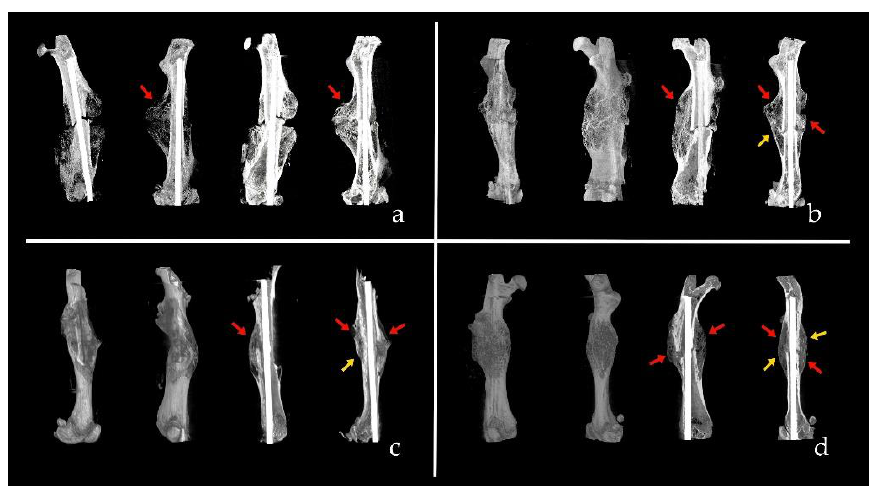
Figure 5. Several examples of consolidation and corticalization scores. ( a ) CT of group A3 (systemic administration of MSCs from osteoarthritis). Score 1-0: One cortex is consolidated and no one corti- calized. ( b ) CT or group A2 (systemic administration of MSCs from osteoporosis). Score 3-1: Three consolidated cortices and one corticalized. ( c ) CT of group B3 (local administration of MSCs from osteoarthritis). Score 3-1: Three consolidated cortices and one corticalized. ( d ) CT of group B2 (local administration of MSCs from osteoporosis). Score 4-2: Four consolidated cortices and two cortical- ized. Red arrows are consolidated cortices and yellow arrows are corticalized cortices.